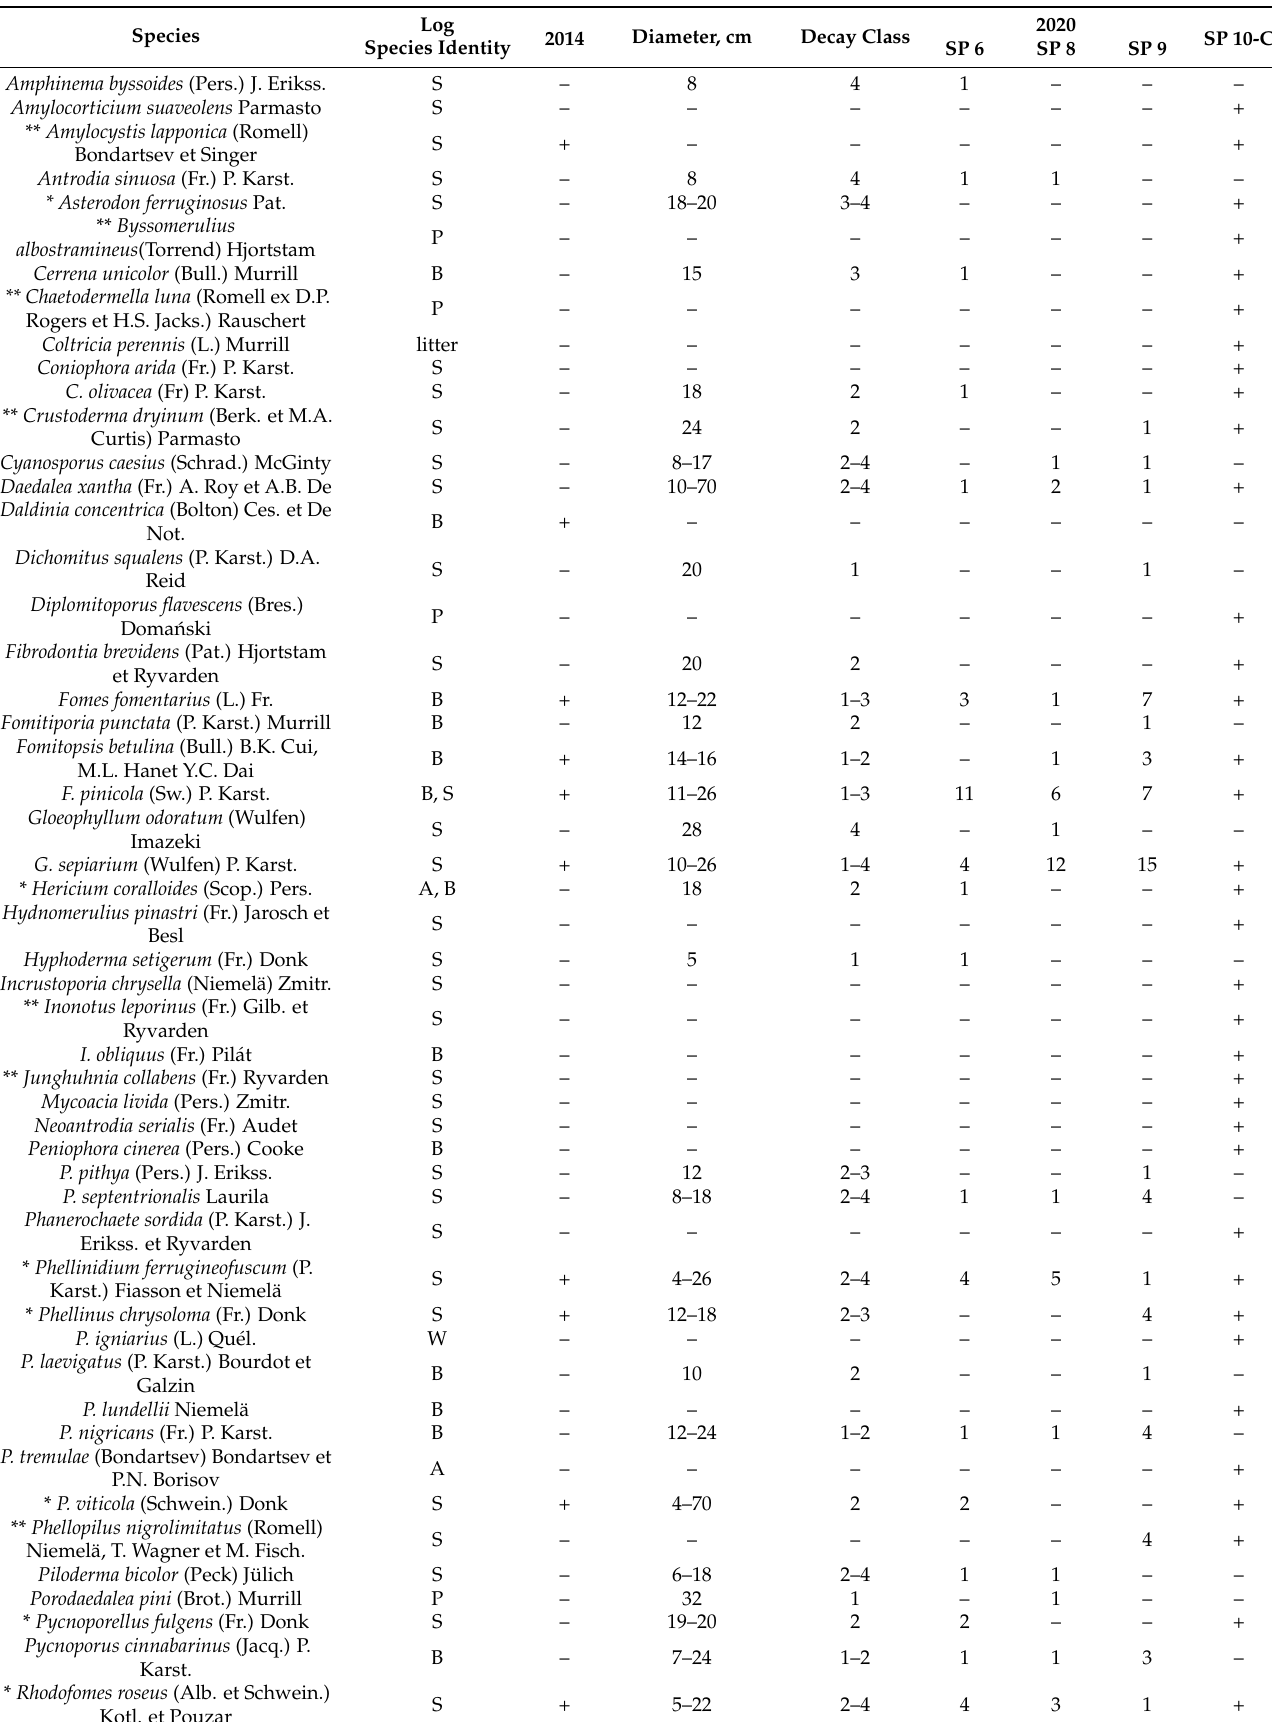
Table 4. Species composition and occurrence of aphyllophoroid fungi in the sample